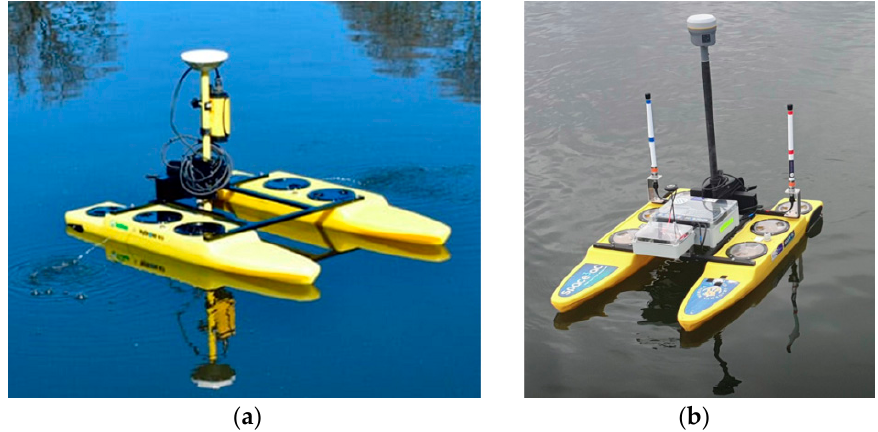
Figure 2. Unmanned Surface Vehicle (USV), before ( a ) and after ( b ) the modernization.